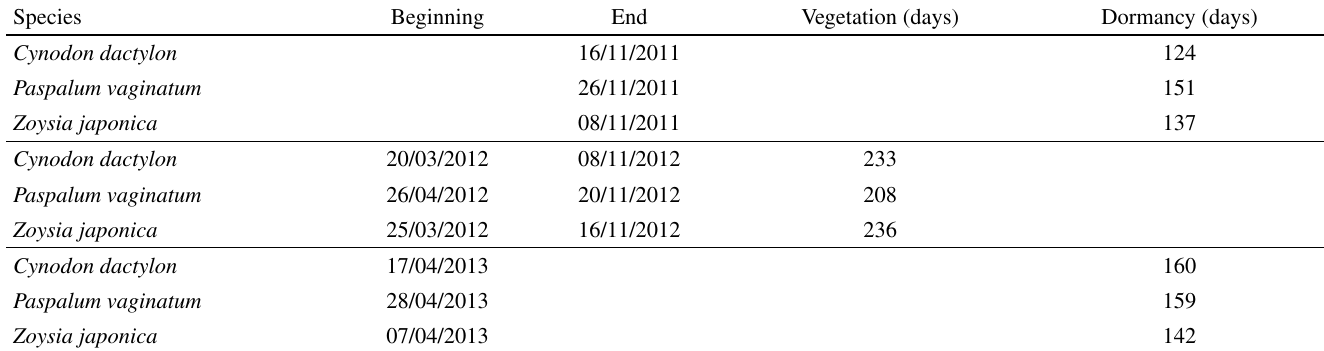
Table 2 - Dates of the beginning and the end of the growing season and length of vegetation and dormancy periods for the species during the years of